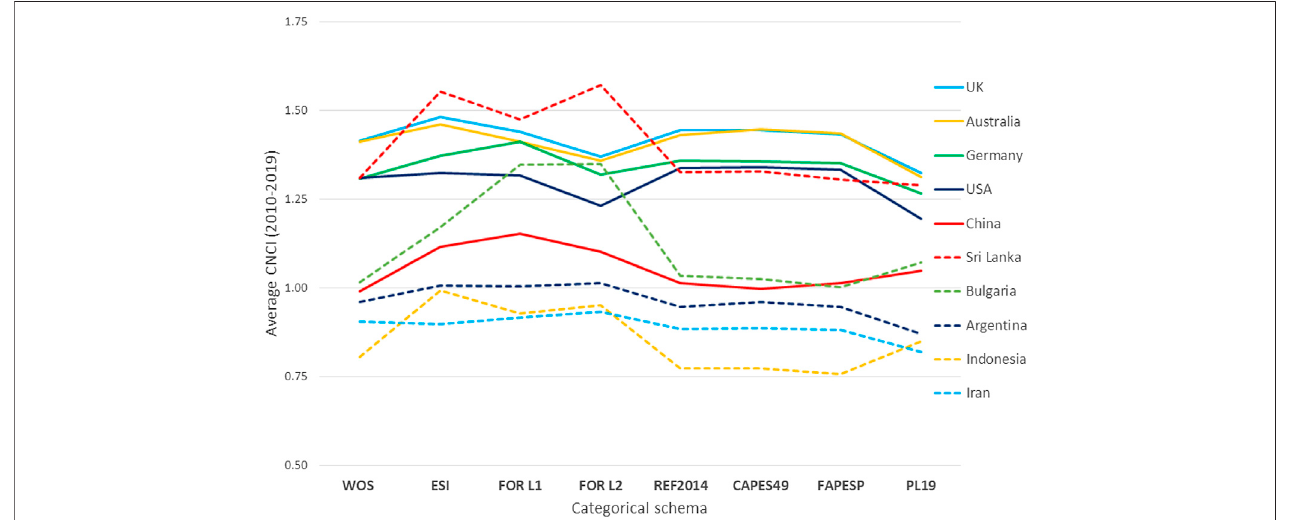
Figure3| TheaverageCategoryNormalizedCitationImpact(CNCI)fortencountriescalculatedwithdatanormalizedundereightdifferentcategoricalschema.The numbersofpublicationsusedtocalculateCNCIvarybetweenschemaasindicatedin Table3 .Thegraphlinesdonotimplyanyconnectionbetweendistinctschemabut are inserted as a visual aid.